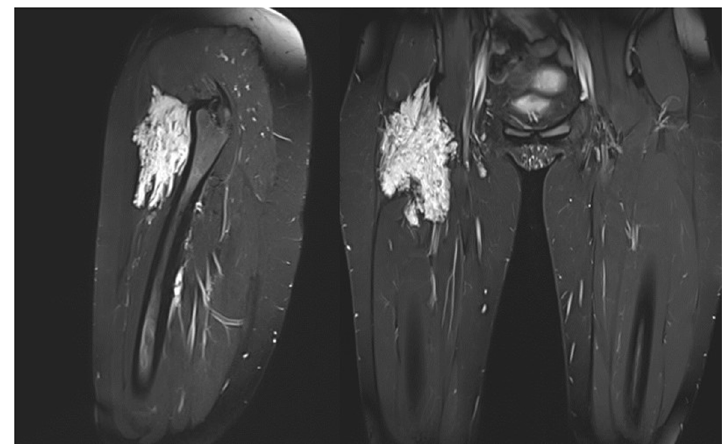
Fig. 4 Imaging of an extensive VM on the right thigh in a 24-year-old